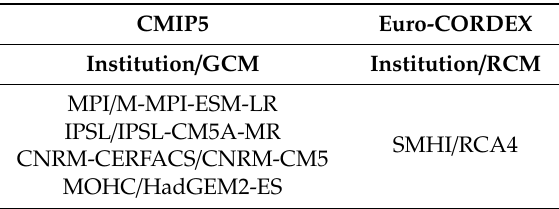
Table 1. Simulations considered in this study. The domains for each region are: Balearic Islands (lon: